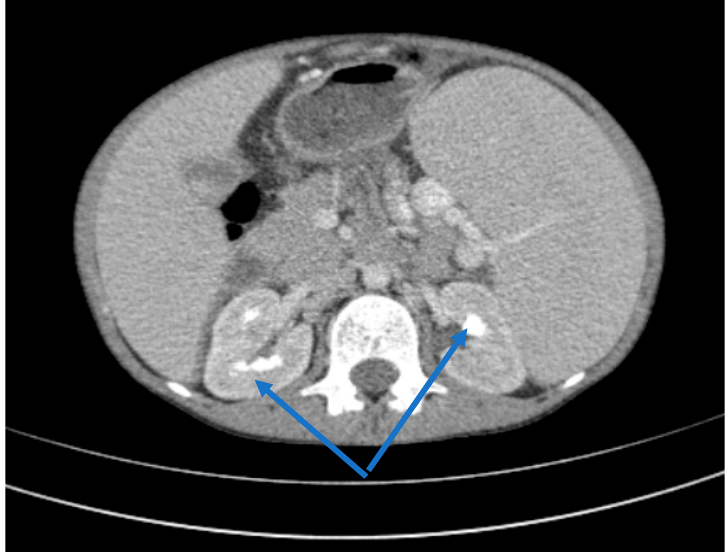
Figure 4. Axial CT scans, portal hypertension (blue arrow).